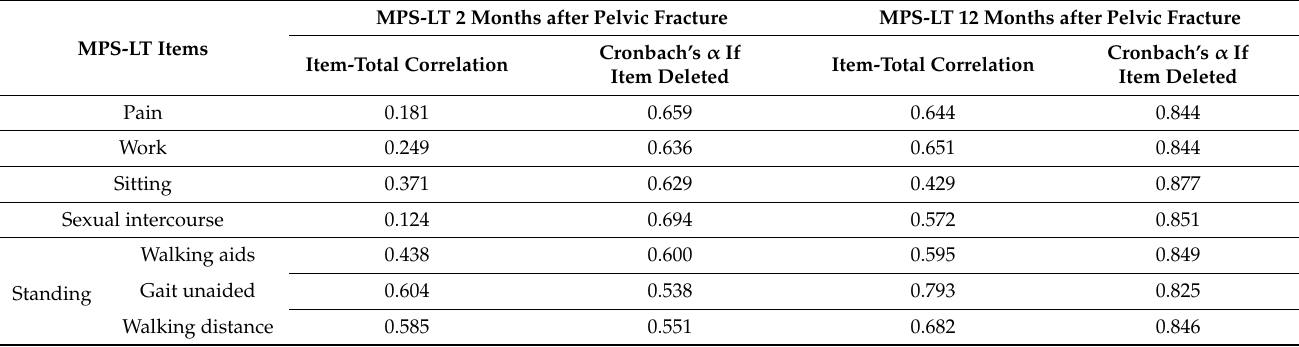
Table 3. Detailed results of item-total and item-removal